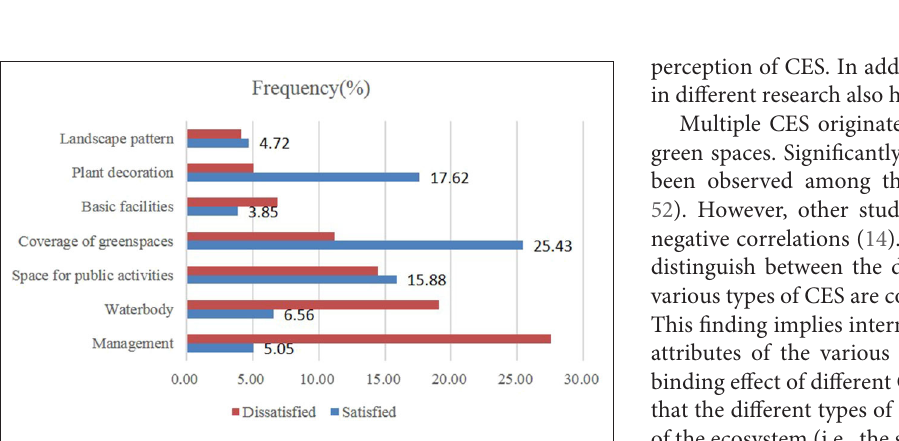
FIGURE 3 | Proportion of respondents who are satisfied and dissatisfied with the quality of residential green